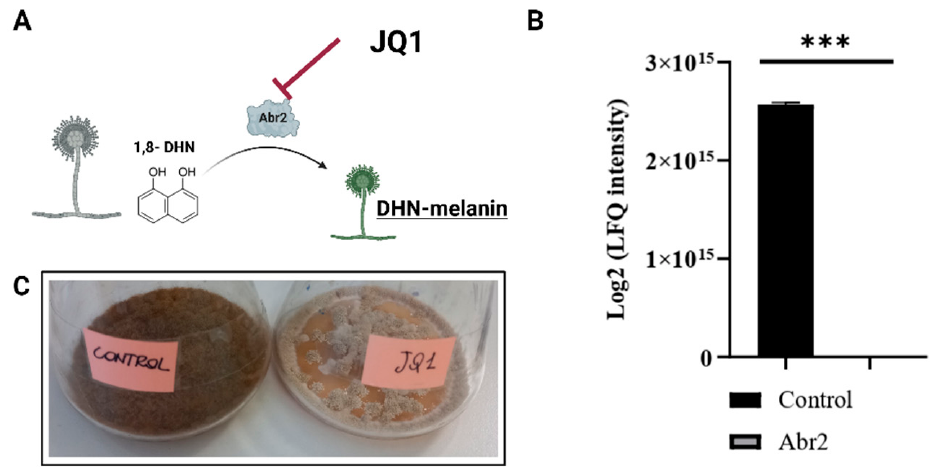
Figure 6. LC-MS/MS results of intracellular proteins of A. fumigatus DSM 790 growth with JQ1 or not. ( A ) Scheme of melanin pathway in A. fumigatus. ( B ) Log2 (LFQ intensity) of Abr2 intracellular fraction after treatment with JQ1. ( C ) A. fumigates DSM 790 growth with or without JQ1. At least three replicates were utilized for each experiment. Unpaired Student t -tests to statistical analysis have been performed. *** p < 0.001 compared to control.